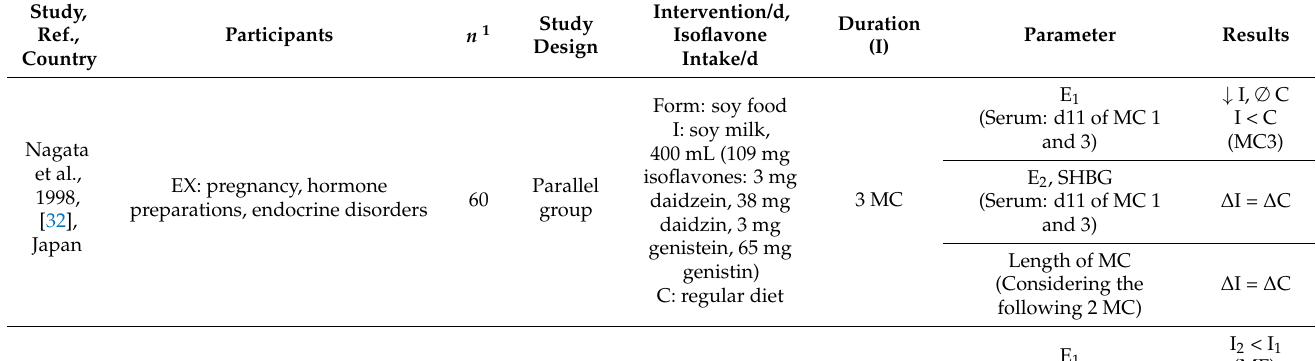
Table 1. Effects of isoflavone intake in premenopausal women on parameters related to the risk of breast cancer. Study,